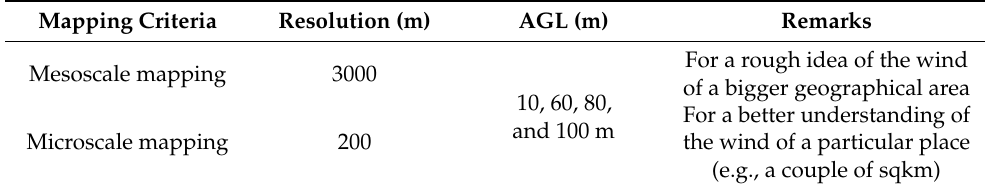
Table 3. Wind resource mapping criteria.